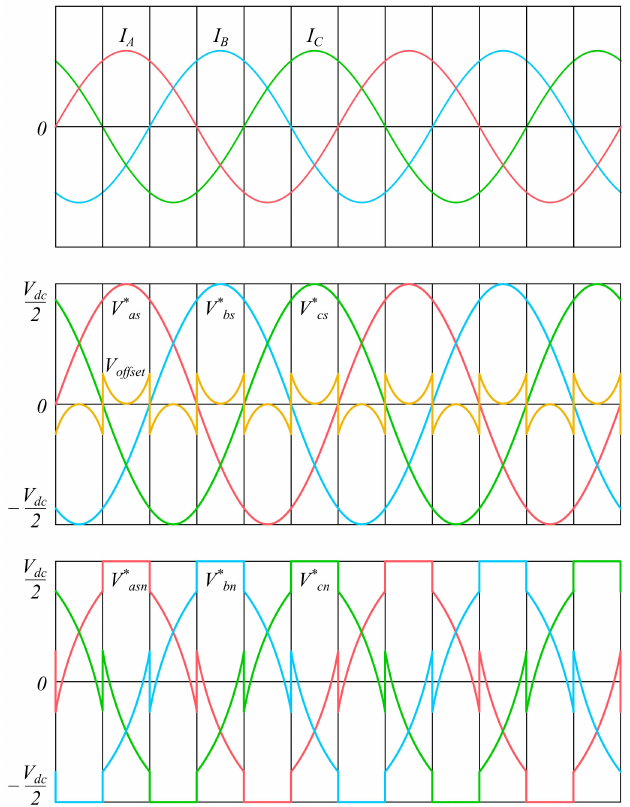
Figure 2. AC-currents, offset voltage, reference voltages, and pole reference voltages of the conventional 60 ◦ discontinuous pulse-width modulation